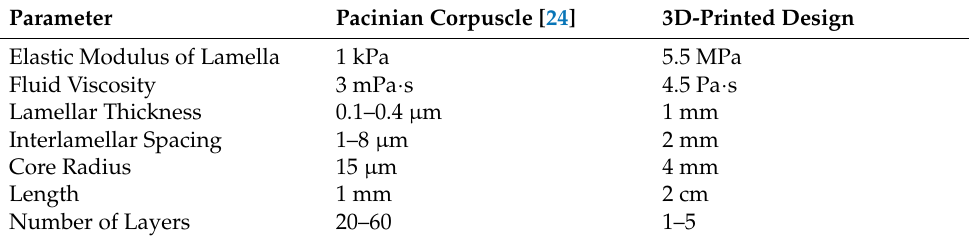
Table 1. Comparison of the parameters of the real Pacinian corpuscle with the artificial design.